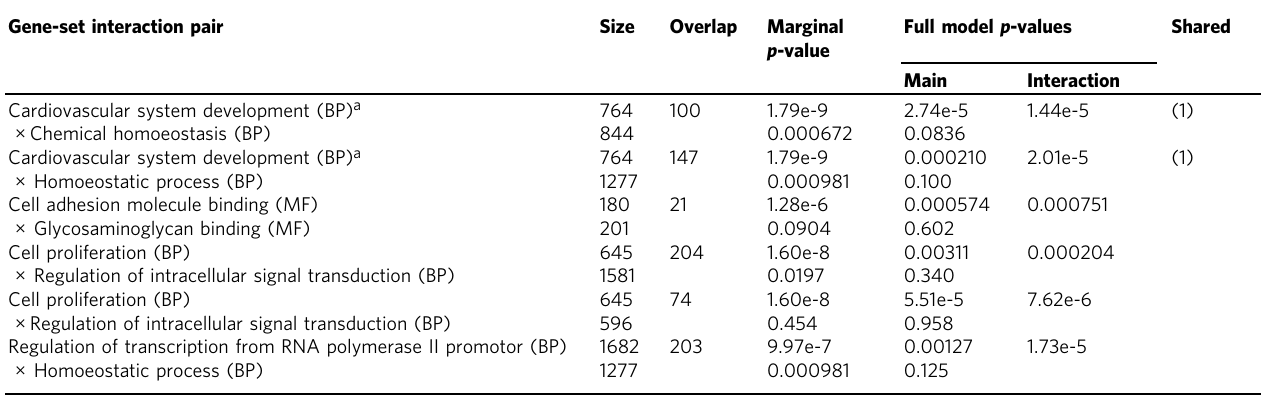
Table 4 Signi fi cant and retained interactions from post hoc gene set by gene set interaction analysis for pulse pressure Gene-set interaction